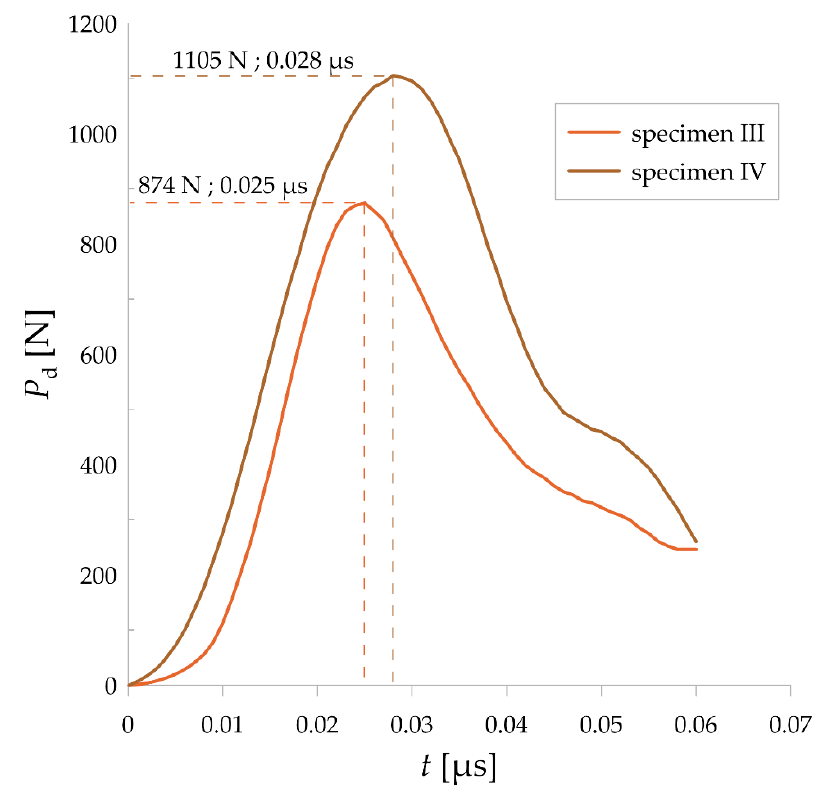
Figure 4. Time-courses of dynamic forces for the two tested SM25T specimens.